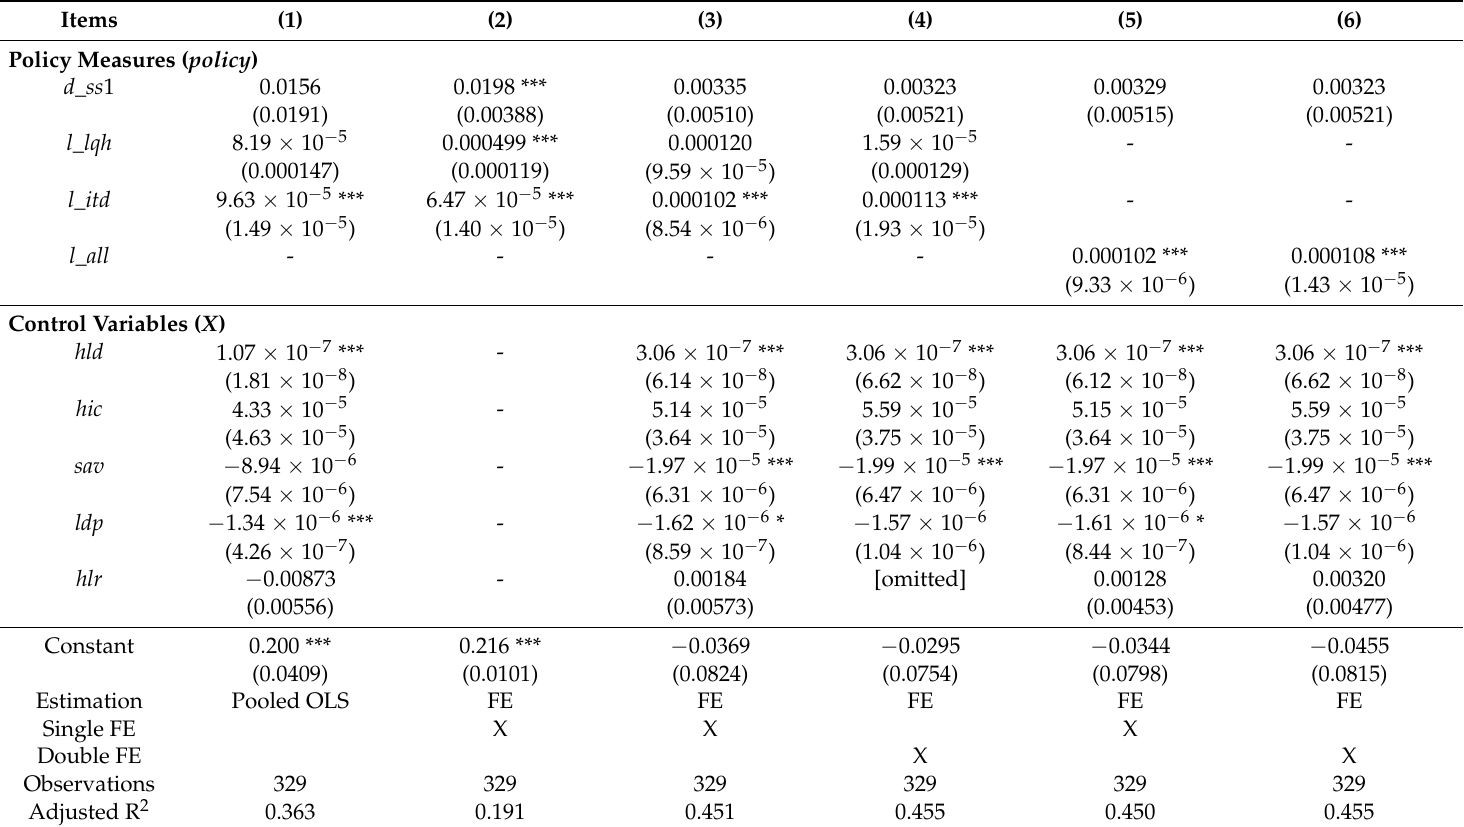
Table 5. Results of the panel data analyses for Case